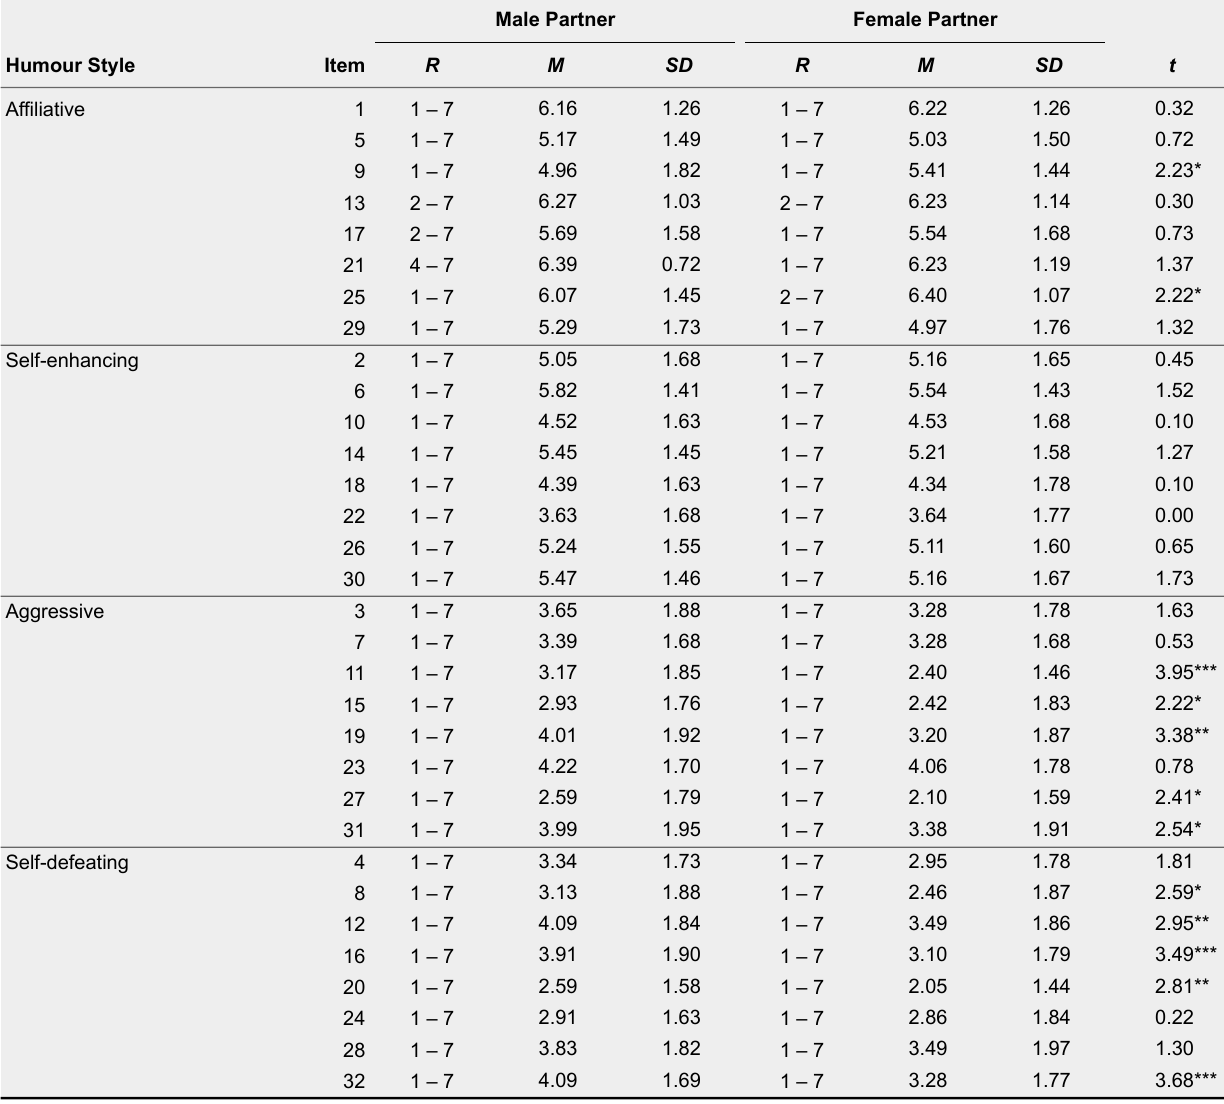
Descriptive Statistics for the 32-Items of the Humour Styles Questionnaire and t-test Results for differences Between